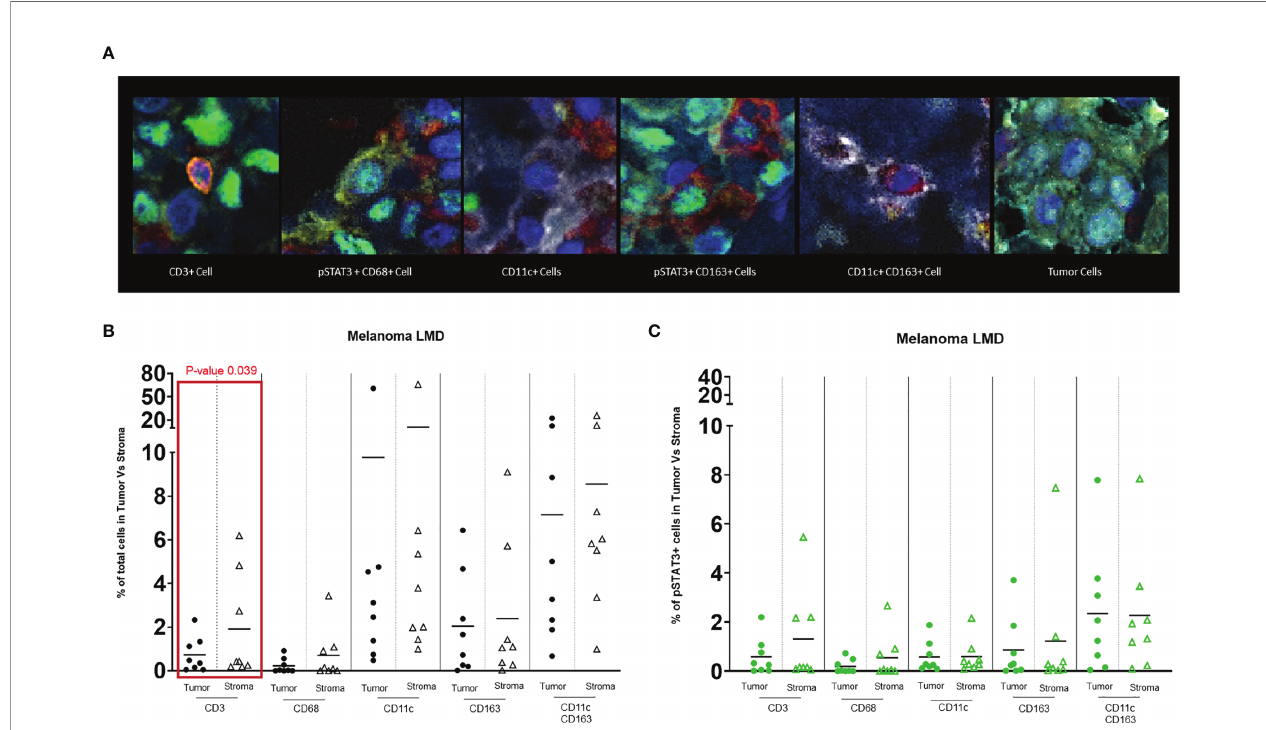
FIGURE 2 | (A) Representative images of different cell populations seen in the TME of melanoma LMD: pSTAT3-CD3+ T cells, pSTAT3+CD68+ macrophages, pSTAT3-CD11c+ APCs, pSTAT3+CD163+ macrophages, pSTAT3-CD11c+CD163+ APCs, and tumor cells demonstrating heterogenous nuclear expression of pSTAT3. (B) Dot-plot representing the percentages of total immune cells in the tumor area vs stroma. The black circles represent the total immune cell populations in the tumor and the black-outlined triangles represent the total immune cells in the stroma. Each circle or triangle represent a specimen. There is a signi fi cant difference between the percentages of CD3+ T cells in the stroma vs in the tumor (p= 0.039). (C) Dot-plot representing percentages of pSTAT3+ immune cells in the tumor area vs stroma. The green circles represent pSTAT3+ immune cell populations in the tumor area and the green-outlined triangles represent pSTAT3+ immune cells in the stroma. Each circle or triangle represent a